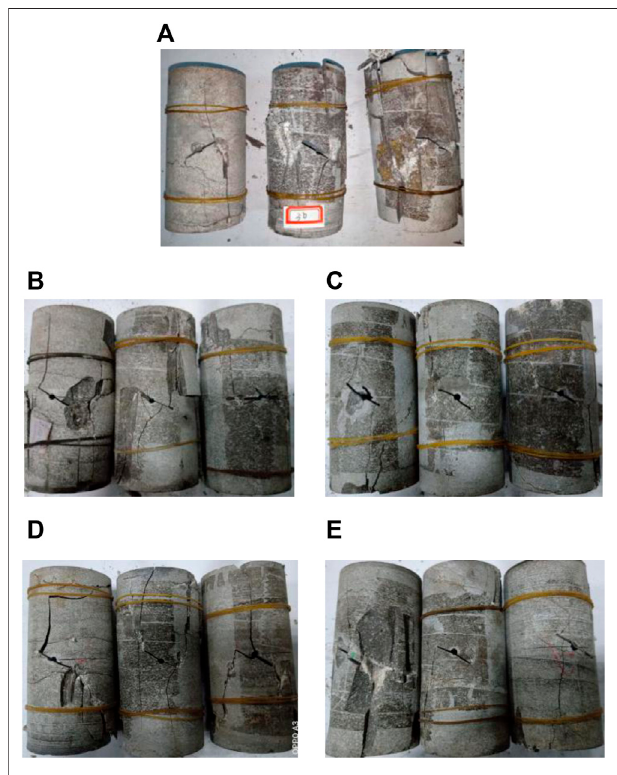
FIGURE 8 | Failure modes of jointed limestone at different water saturation times. (A) Dry. (B) 1 day. (C) 3 days. (D) 5 days. (E) 7